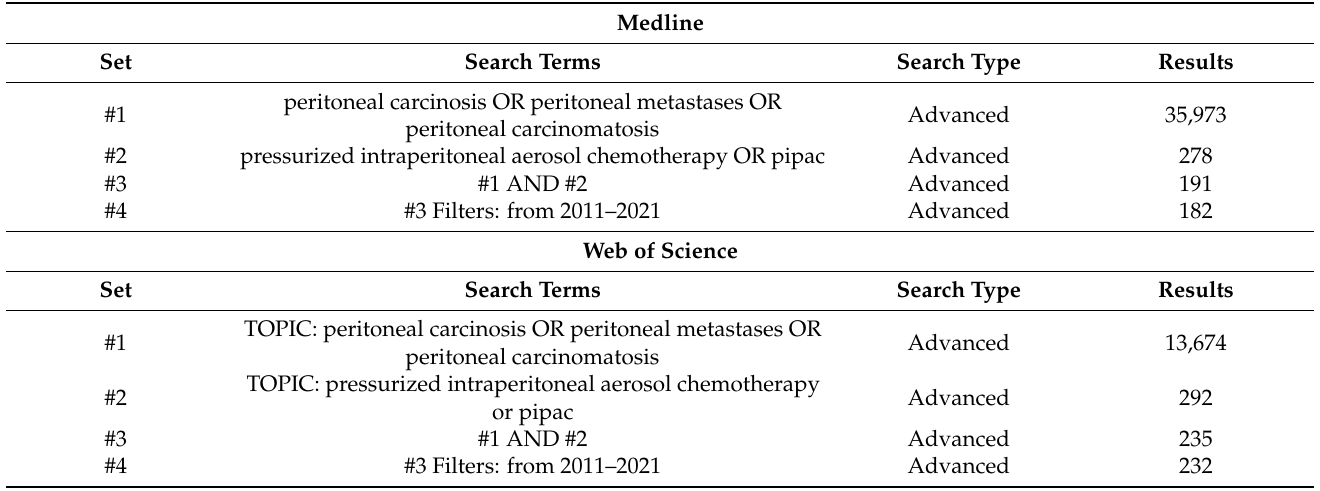
Table 1. String search strategy for Medline and Web of